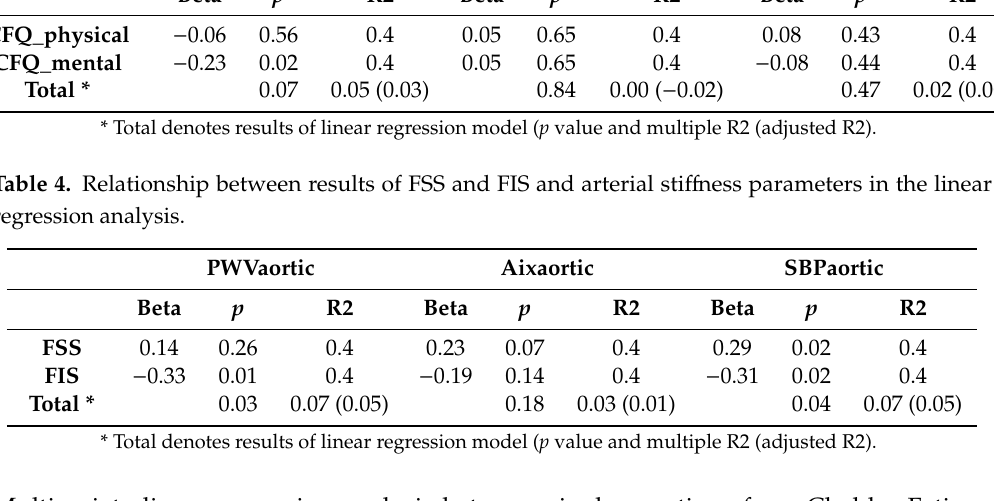
Table 3. Relationship between results of mental and physical fatigue from the CFQ scale and arteriography in linear regression analysis. PWVaortic Aixaortic SBPaortic Beta p R2 Beta